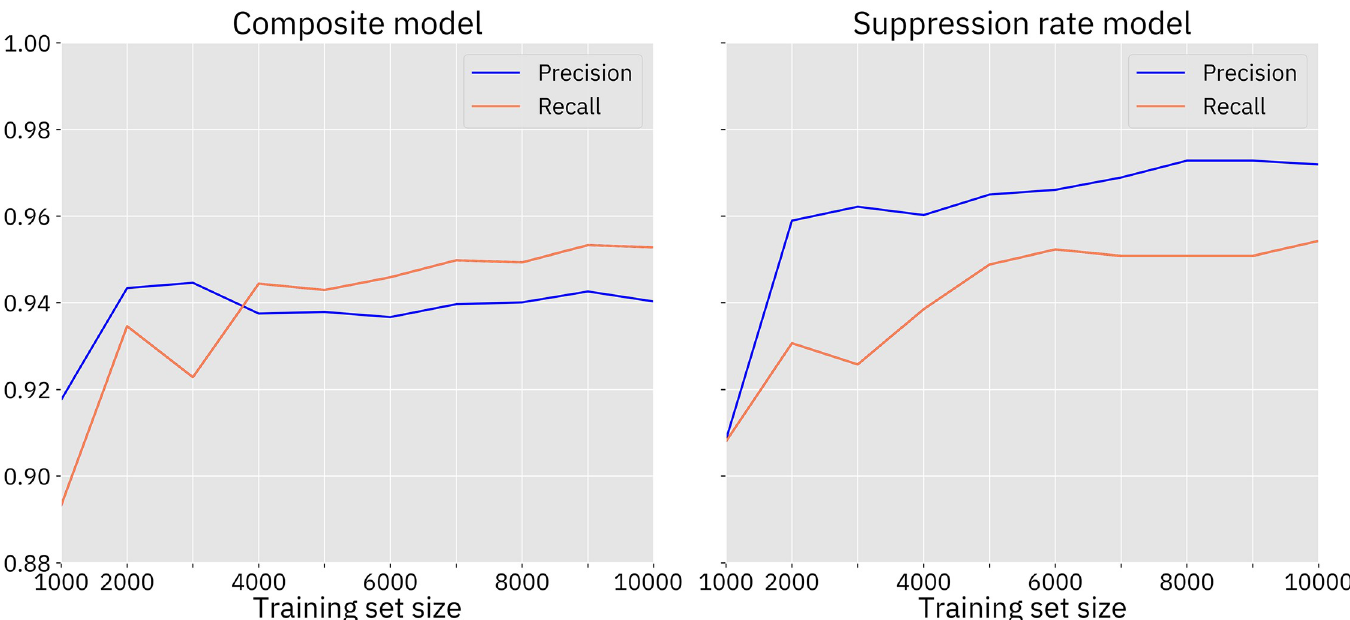
Fig 6. Model quality, female fertility homing drive without resistance. The model was evaluated against the 10000-point Latin Hypercube sampled test set. This drive has a larger area of success than all of the other drives, and thus, the GP model performs relatively well, even before adaptive sampling, compared to the other models. The first few adaptively sampled data sets substantially improved the performance of the model, after which improvements were smaller. See S1 Fig for similar plots for the other models.